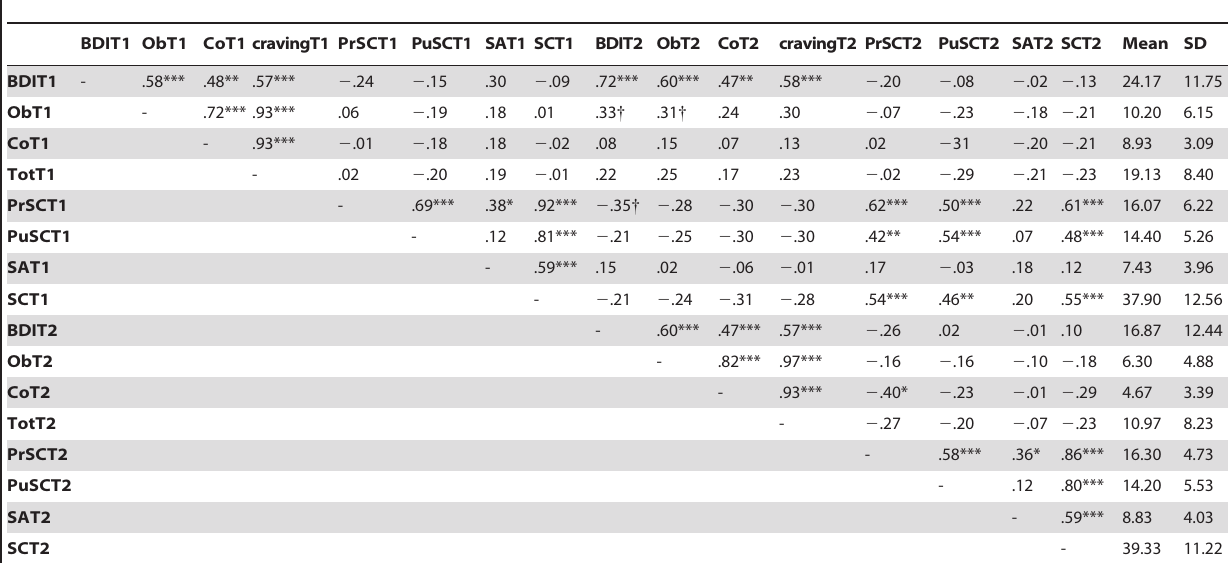
Table 1. Correlation matrix between variables at T1&T2 with each variables overall Mean and SD at